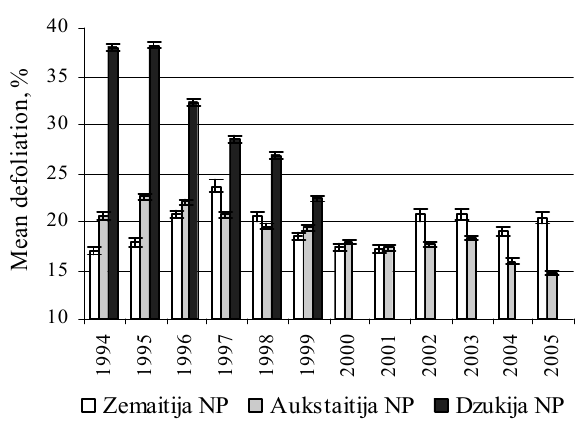
FIGURE 2. Mean value and standard errors of pine defoliation in Lithuanian national